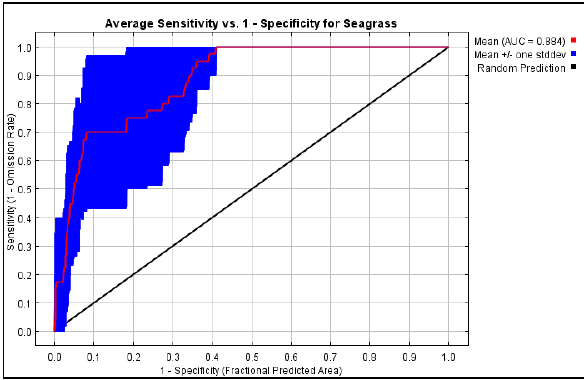
Figure 6. Seagrass habitat suitability model produced by MaxEnt